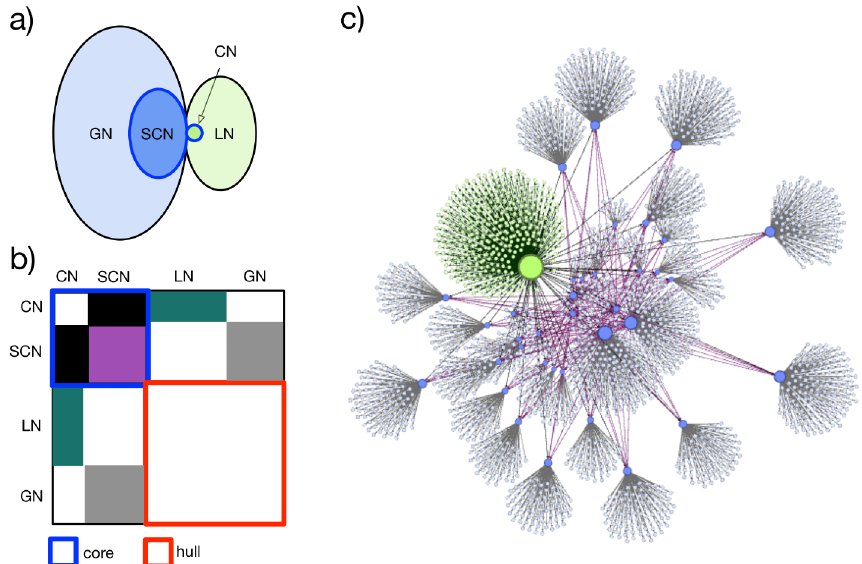
Fig 1. (a) A semantic concept (SC) is represented by Wikipedia pages regarding the same topic in different languages (semantic core nodes, SCN, blue). One node from the SCN, i.e. a specific language, is selected as central node (CN, green) and separated from the SCN. All pages in the same language directly linked to the CN make up the local neighborhood (LN, light green), while all pages directly linked to the other SCN make up the global neighborhood (GN, light blue). (b) Schematic representation of the corresponding adjacency matrix. SCN and CN combined are called multilingual semantic core , while LN and GN form the hull . The pages in the core are connected via inter-language links (ILL, black for links involving CN and purple for links among SCN). Links between CN and LN are shown in green, while links between SCN and GN are shown in gray. All other links are ignored because only the nearest neighborhood is taken into account. (c) Network representation using the same colors as in parts (a, b). The network representation allows an inspection of the dataset, before group definitions are finalized. A qualitative interpretation and a quantitative measurement of network properties helps to evaluate the impact of separation into sub-networks, e.g. to prepare data for time resolved relevance